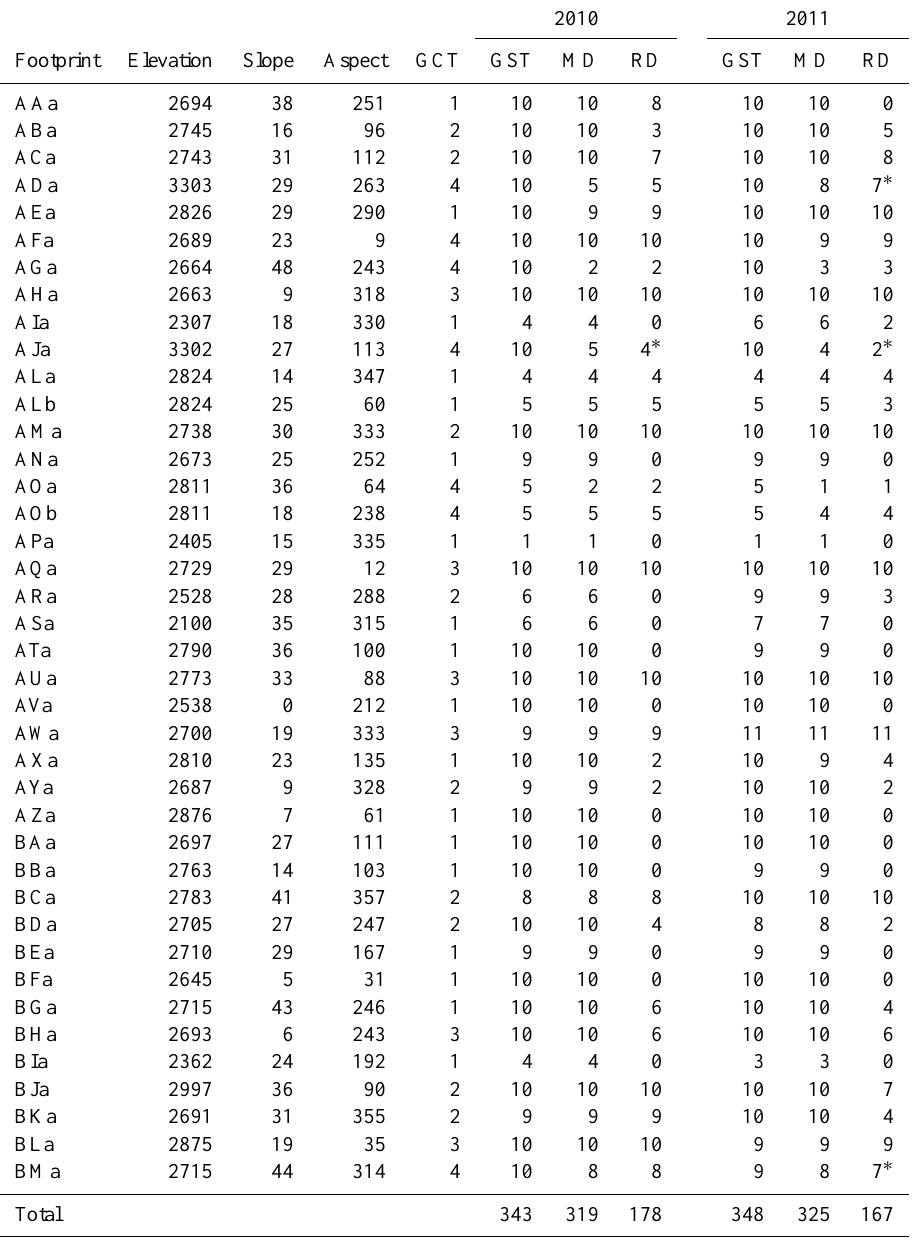
Table 3. List of footprints and the amount of GST, MD and RD values derived. The lack of an insulating snow cover resulted in iButtons where MD was not detected. The lack of a clearly frozen ground resulted in snow covered iButtons where RD was not detected, except for some locations with GCT4 where no zero curtain phase occurred (marked with ∗ ). Elevation, slope angle and slope exposition are based on a 10m digital elevation